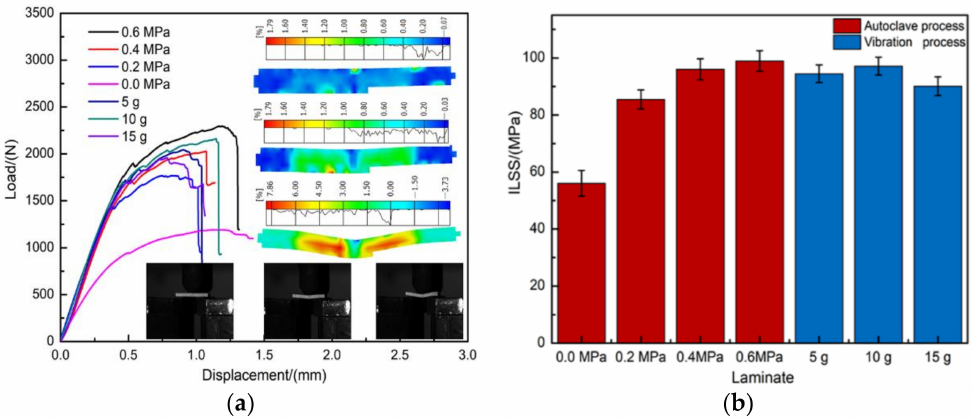
Figure 9. ( a ) Experimental load-displacement curve of composite specimens with different curing cycles; the insert is the result obtained by DIC, ( b ) measurement of ILSS for different curing